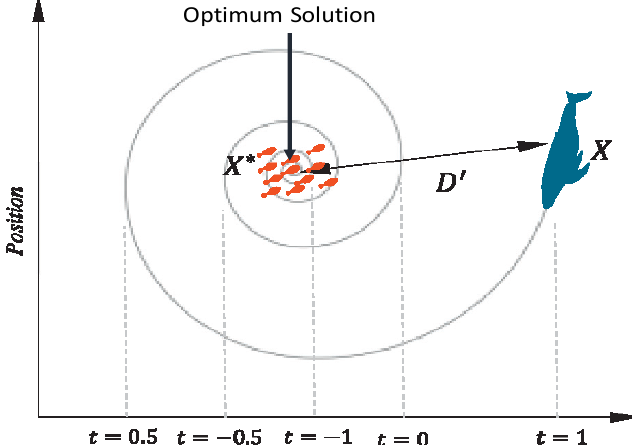
Figure 2. Humpback whale bubble net hunting strategy.